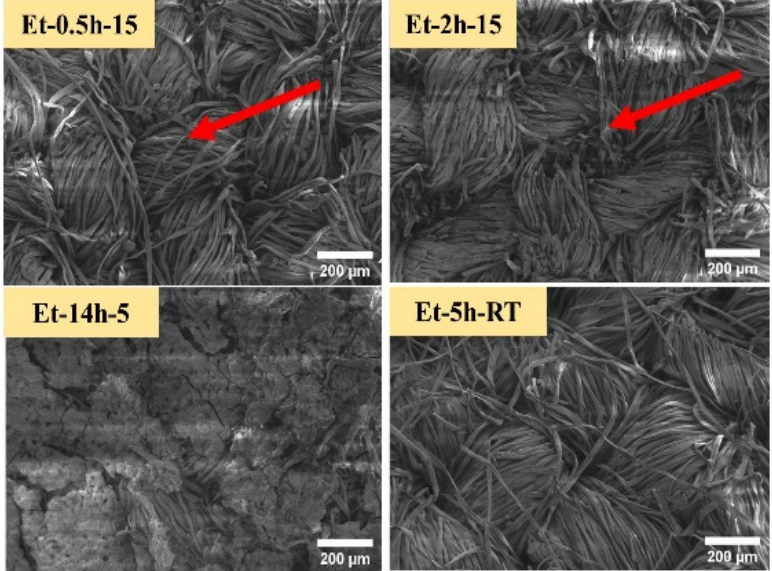
Figure 2. SEM iamges of the cotton fabric obtained under various conditions.